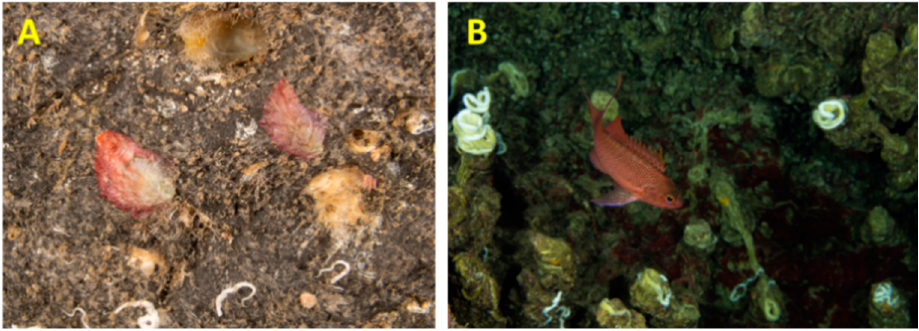
Figure 3. The bivalve Neopycnodonte cochlear ( A ), serpulid bioconstructions and a cardinal fish Anthias anthias individual ( B ) photographed in the semi-dark zone of Alona and Panteleimonas caves, respectively. Photos by T. Dailianis.